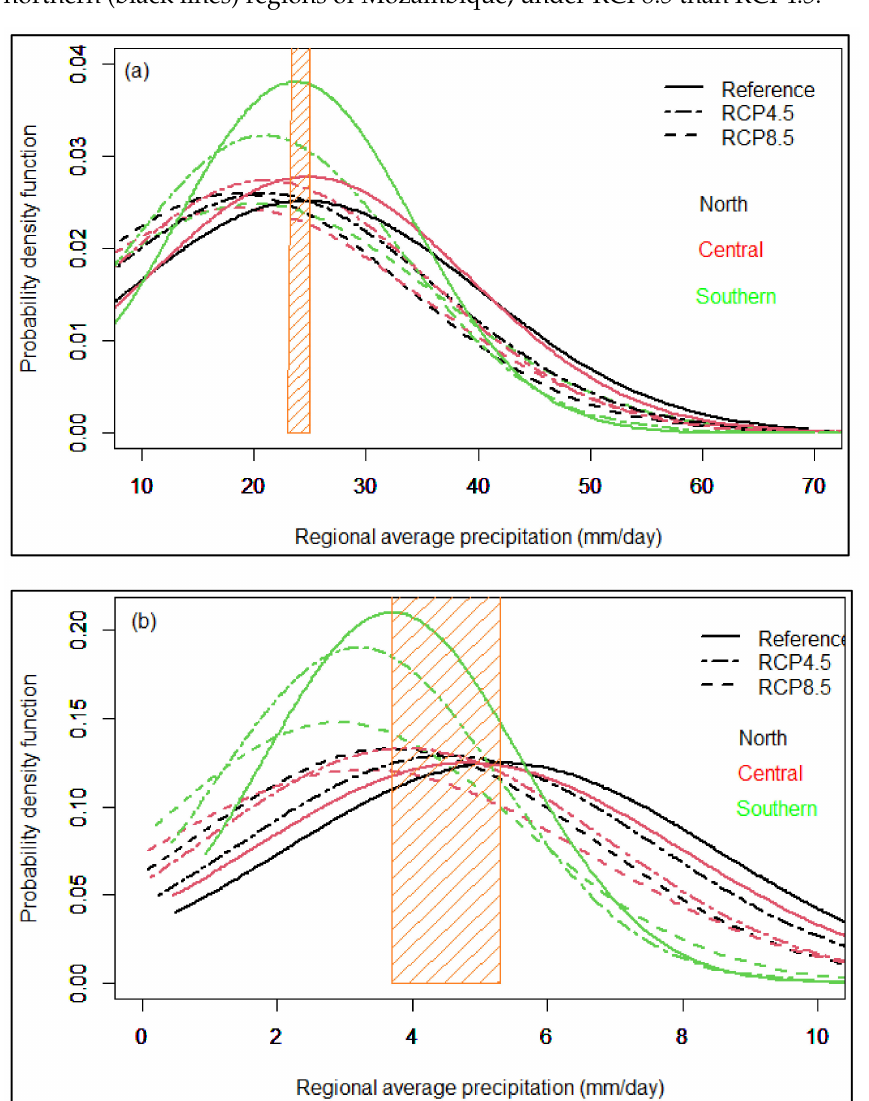
Figure 12. Probability density function of maximum ( a ) and mean ( b ) regional precipitation distribu- tion in the three regions (northern represented by black line, central by red line and green line for southern) over the study domain. The precipitation between shaded vertical bands represent the range of regional mean precipitation for reference